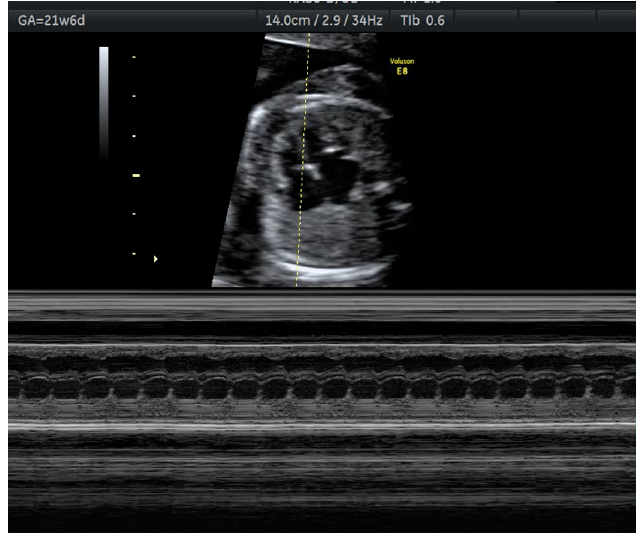
Figure 2. Foetal ultrasound M mode-foetal complete heart block in a pregnancy of 21 weeks of a mother with anti-Ro antibodies.